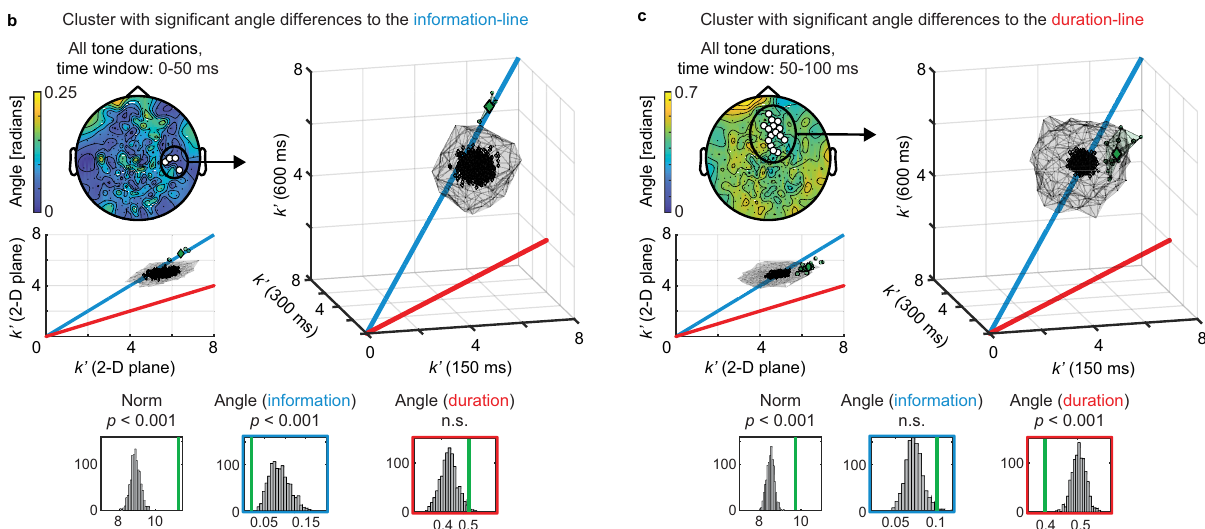
Fig. 5 Sensory history integration operates differently across spatial locations, but predictive processing clusters exhibit fl exible scaling to sensory input rate ( n = 20 participants). a Across-tone duration-condition comparison of the number of preceding tones best explaining neuromagnetic activity ( k 0 -values) from the left and right predictive processing cluster (300 ms tone duration condition, 50 – 100 ms time window). k 0 -values from experimental data in both sensor clusters (3-D and 2-D plots, green dots) reside signi fi cantly (top histograms, p < 0.001, nonparametric permutation test, one-tailed) further away from origin at k 0 ≈ 6 (i.e., 7 integrated tones) than shuf fl ed data (gray dots). Experimental k 0 -values in the left sensor cluster reside signi fi cantly closer to the information line than shuf fl ed data (left middle histogram, p = 0.014, nonparametric permutation test, one-tailed). Additional results from predictive processing clusters de fi ned using other time windows are shown in Supplementary Fig. 5. b A data-driven analysis across the entire sensor array identi fi ed a sensor cluster in which SHI behaves according to the informational bottleneck hypothesis. This sensor cluster overlaps with the right predictive processing cluster shown in a . Topoplot shows the angle between experimental data and the information line for all sensors. Signi fi cant sensors where the angle is smaller than shuf fl ed data are shown in white ( p < 0.05, cluster-based permutation test, one-tailed). Here, k 0 -values reside signi fi cantly further away from origin (left histogram, p < 0.001) and signi fi cantly closer to the information line than shuf fl ed data (middle histogram, p < 0.001). c A sensor cluster in which SHI behaves according to the temporal bottleneck hypothesis, identi fi ed by the data-driven analysis. This sensor cluster has minimal overlap with the predictive processing clusters. Topoplot shows the angle between experimental data and the duration line for all sensors, and signi fi cant sensors where the angle is smaller than shuf fl ed data are shown in white ( p < 0.05, cluster-based permutation test, one-tailed). Here, k 0 -values reside signi fi cantly further away from origin (left histogram, p < 0.001) and signi fi cantly closer to the duration line than shuf fl ed data (right histogram, p <